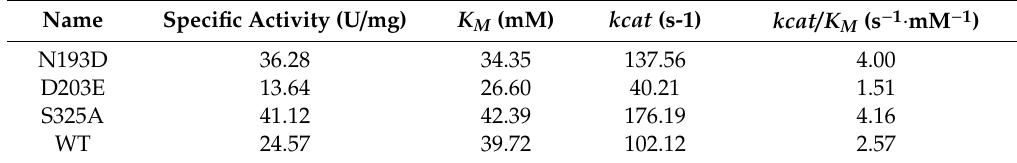
Table 2. The specific activity and kinetic constants of wild type and its